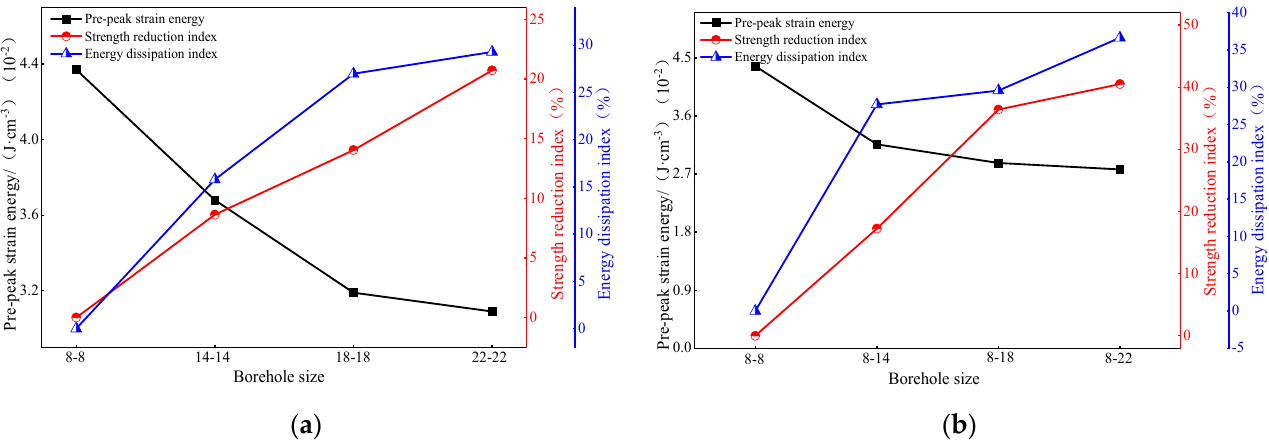
Figure 8. The variation curve of each index of each drilled sample: ( a ) is the variation curve of each index of same-diameter drilled sample; ( b ) is the variation curve of each index of variable-diameter drilled sample.